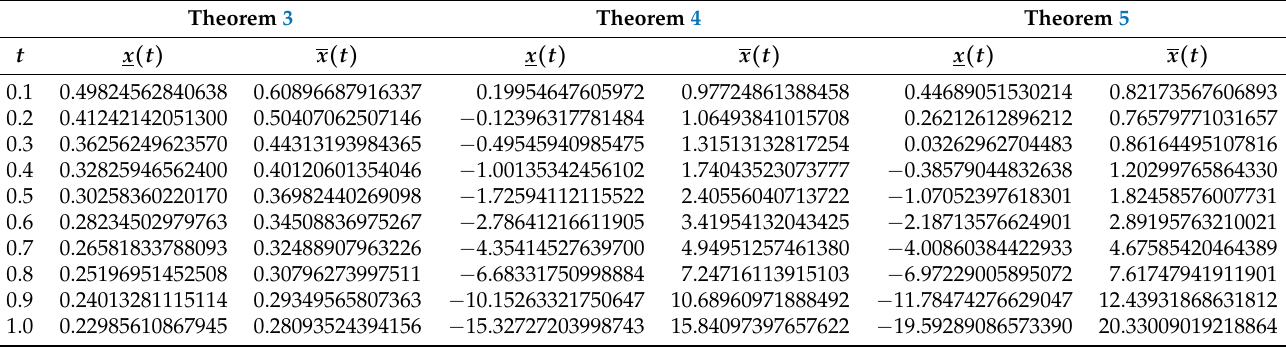
Table 2. Comparison of all verified solution techniques for the example (37) with (38) and ν = 0.5. Theorem 3 Theorem 4 Theorem